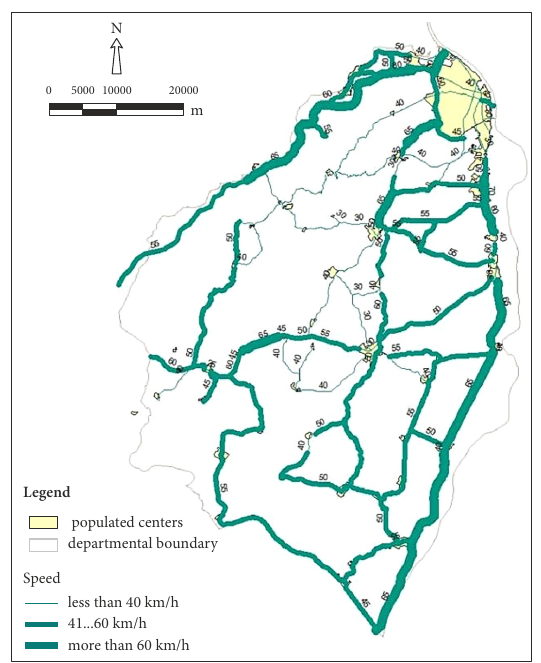
Figure 4. Speed limits on